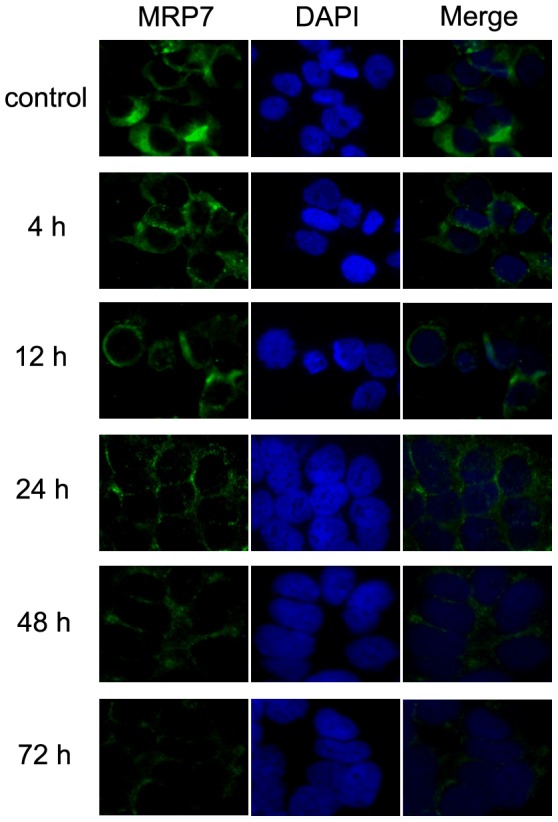
Effect of tariquidar treatment on the subcellular localization of MRP7.HEK/MRP7 cells were treated with 0.3 µM tariquidar for different periods of time. The subcellular localization of MRP7 was analyzed by immunofluorescence. MRP7 staining is shown in green. DAPI (blue) counterstains the nuclei.